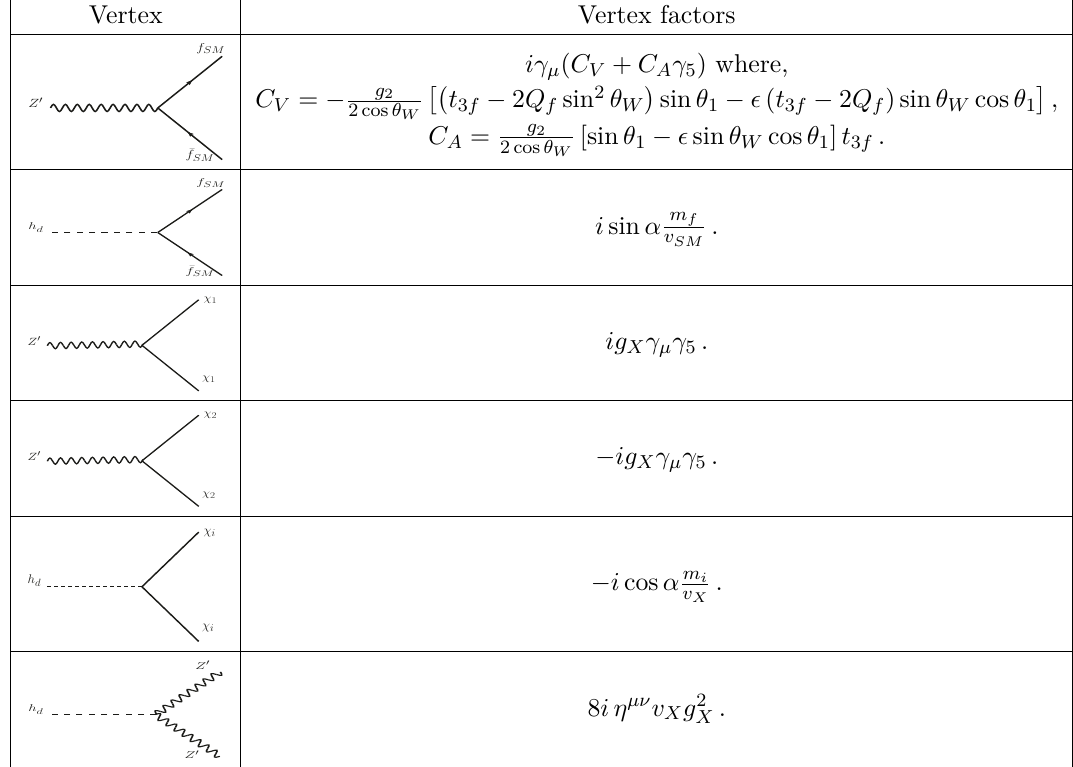
Table 2 . All important vertices required for computations of 2 → 2 , 3 → 2 scatterings and two- body decay